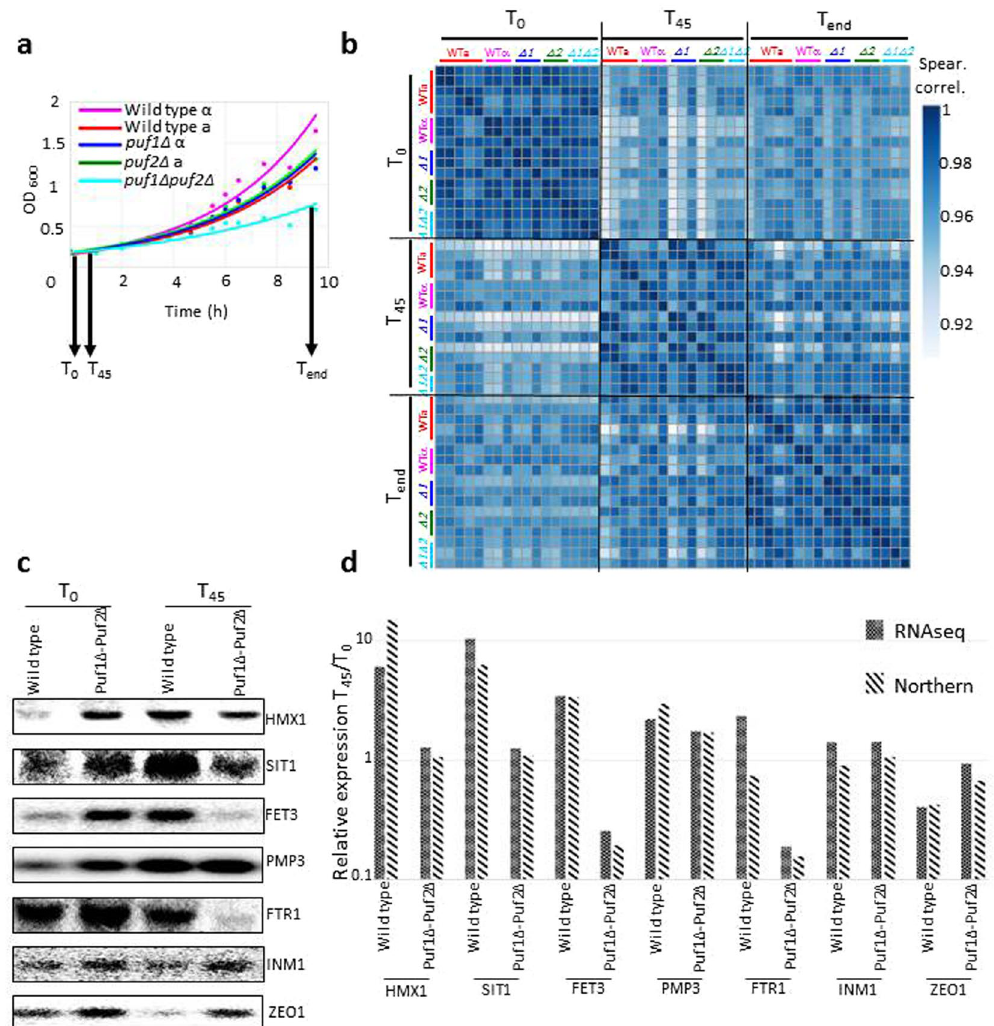
Figure 4. RNA-seq reproducibility and validation. ( a ) Growth curves of the five strains (yA635, yA995, yA1382, yA637, yA639) that were subjected to RNA-seq analysis. RNA was isolated before the addition of 0.3 M CaCl 2 (T 0 ), after 45 minutes of CaCl 2 addition (T 45 ), and after ~9 hours (T end ). Samples were subjected to RNA- seq or northern analyses. ( b ) Spearman’s correlation heatmap of unclustered RNA-seq biological replicates for all strains at three timepoints. Note that the scale of the Spearman values starts at 0.9. Actual values are provided in Supplementary Table 2. ( c ) Northern analyses of total RNA extracted from wild-type (yA635) and puf1 Δ puf2 Δ (yA639) strains for untreated (T 0 ) and 0.3 M CaCl 2 treated (T 45 ) samples. Radiolabeled PCR products of the genes indicated to the right were used as probes. ( d ) Bands in the northern blot ( c ) were quantified with ImageQuant, and the ratio for the signals at T 45 to T 0 are presented for each gene (stripes). RNA-seq results (weave) for the same genes from the same biological replica are presented. Compatibility of the results was calculated using Pearson correlation ( p value =